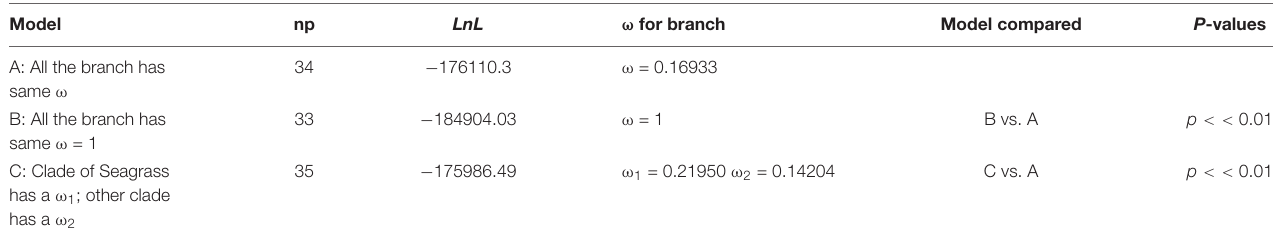
Model np LnL ω for branch Model compared P